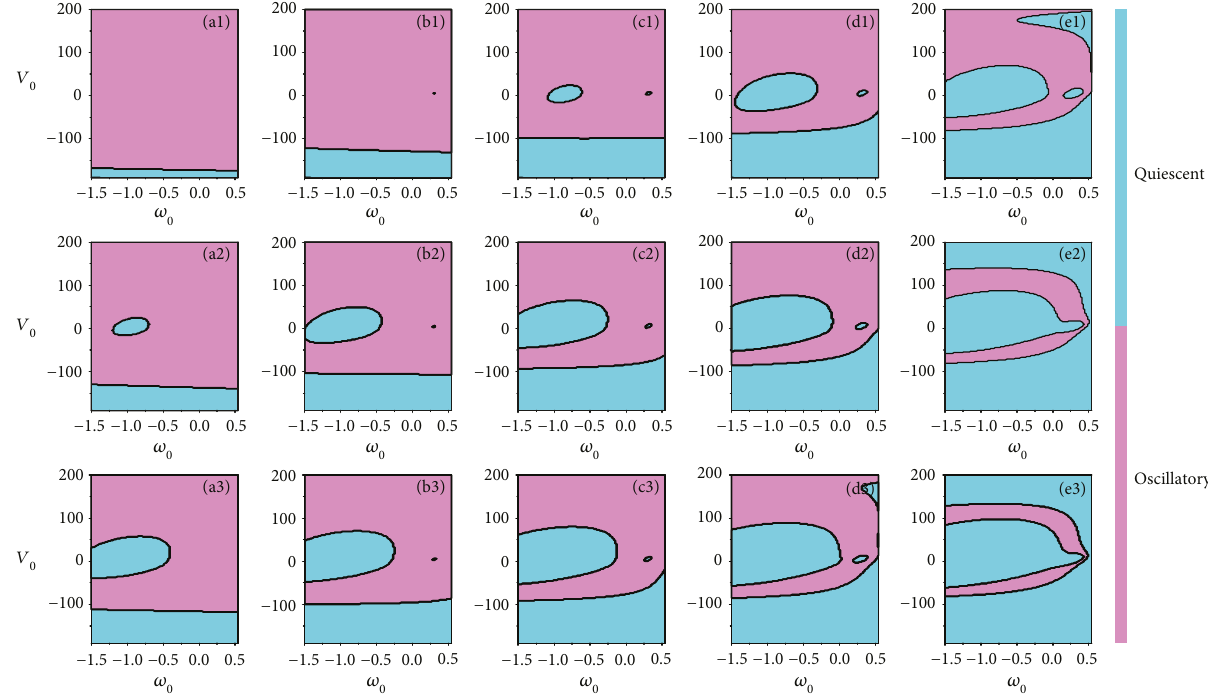
Figure 4: The regional distribution diagram of the resting state and oscillating state under di ff erent initial values at φ k = 0 2 and I ext = 30 , 40, 50, 60, and 70; for (a2 – e2) k = 0 3 and I ext = 30 , 40, 50, 60, and 70; and for (a3 – e3) k = 0 4 and I ext = 30 , 40, 50, 60, and 70.